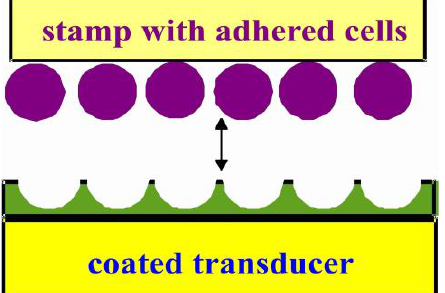
Figure 1. A QCM coated with a pre-polymer followed by surface patterning with a stamp possessing adhered cells.